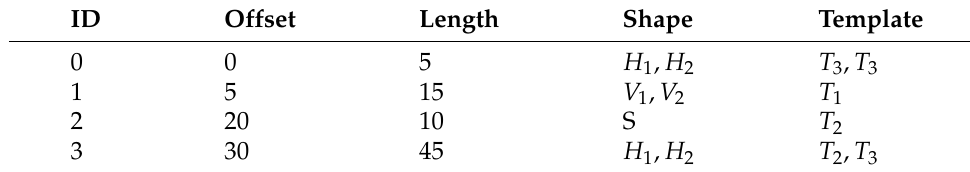
Table 2. Meta file structure.